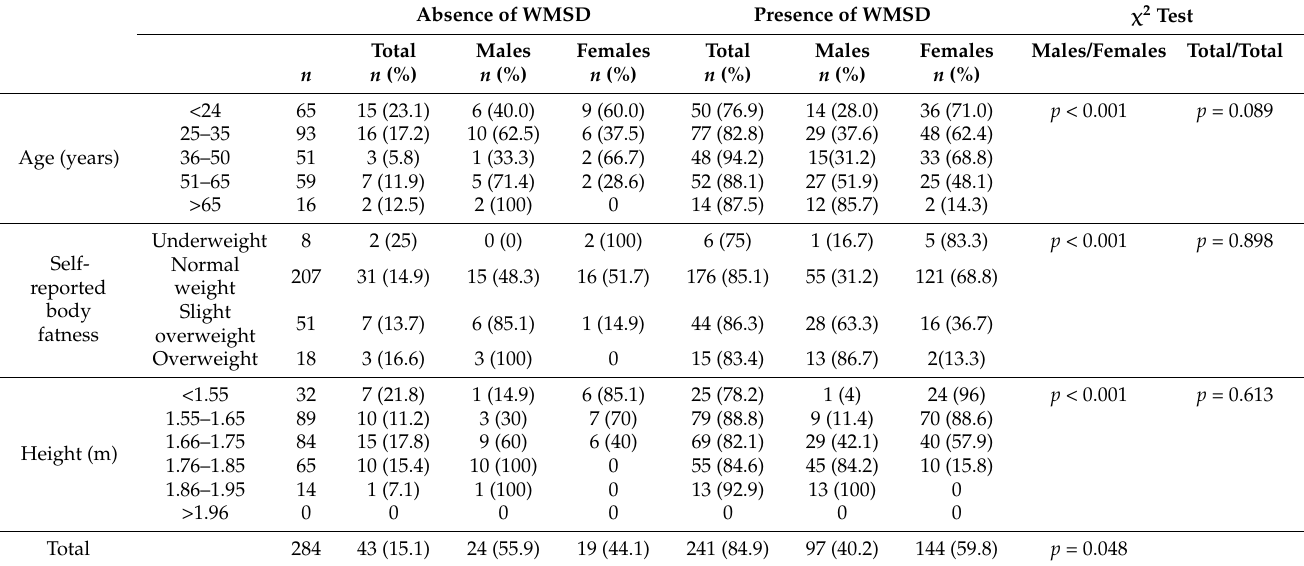
Table 2. Prevalence of WMSD in the past 12 months according to anthropometric parameters (statistical significance for p < 0.05). Females showed a significantly higher percentage of WMSD when compared to males ( p <